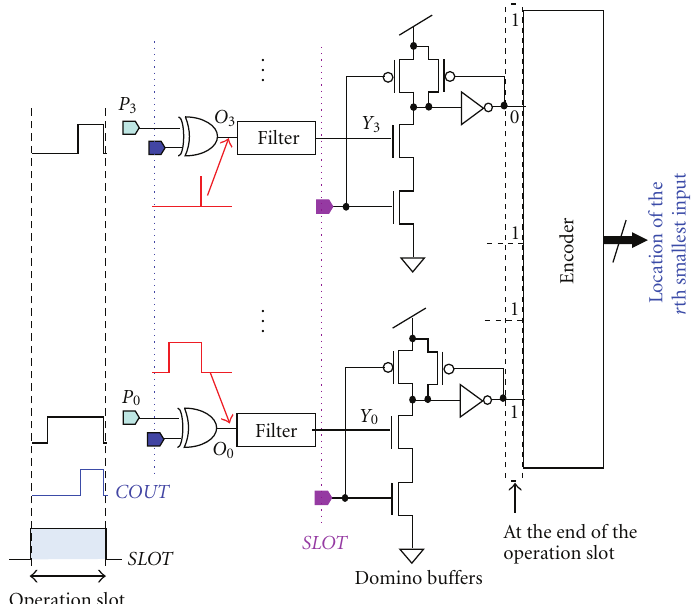
F 3: Demonstration of the rank-order searching